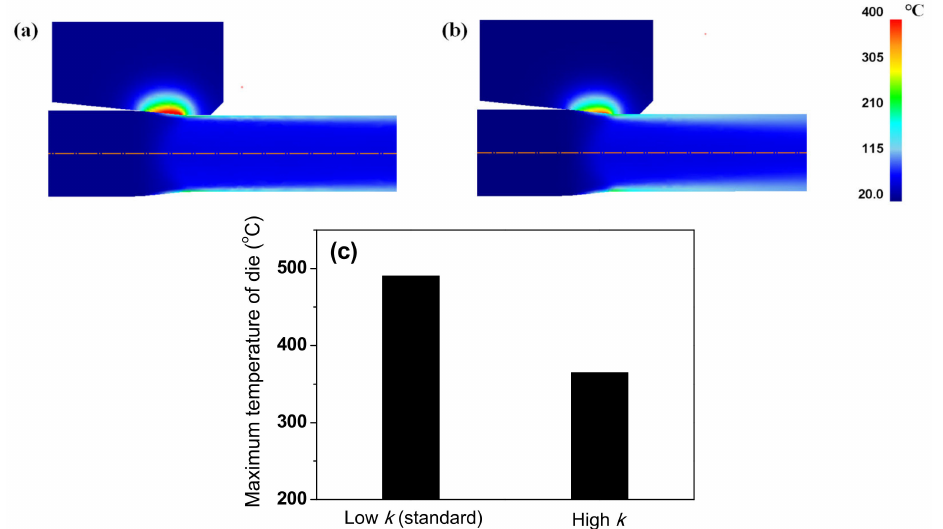
Figure 16. Comparison of temperature contour of TWIP steel with ( a ) low and ( b ) high thermal conductivities at drawing speed of 0.7 m/s. ( c ) Comparison of maximum temperature of die between two drawing